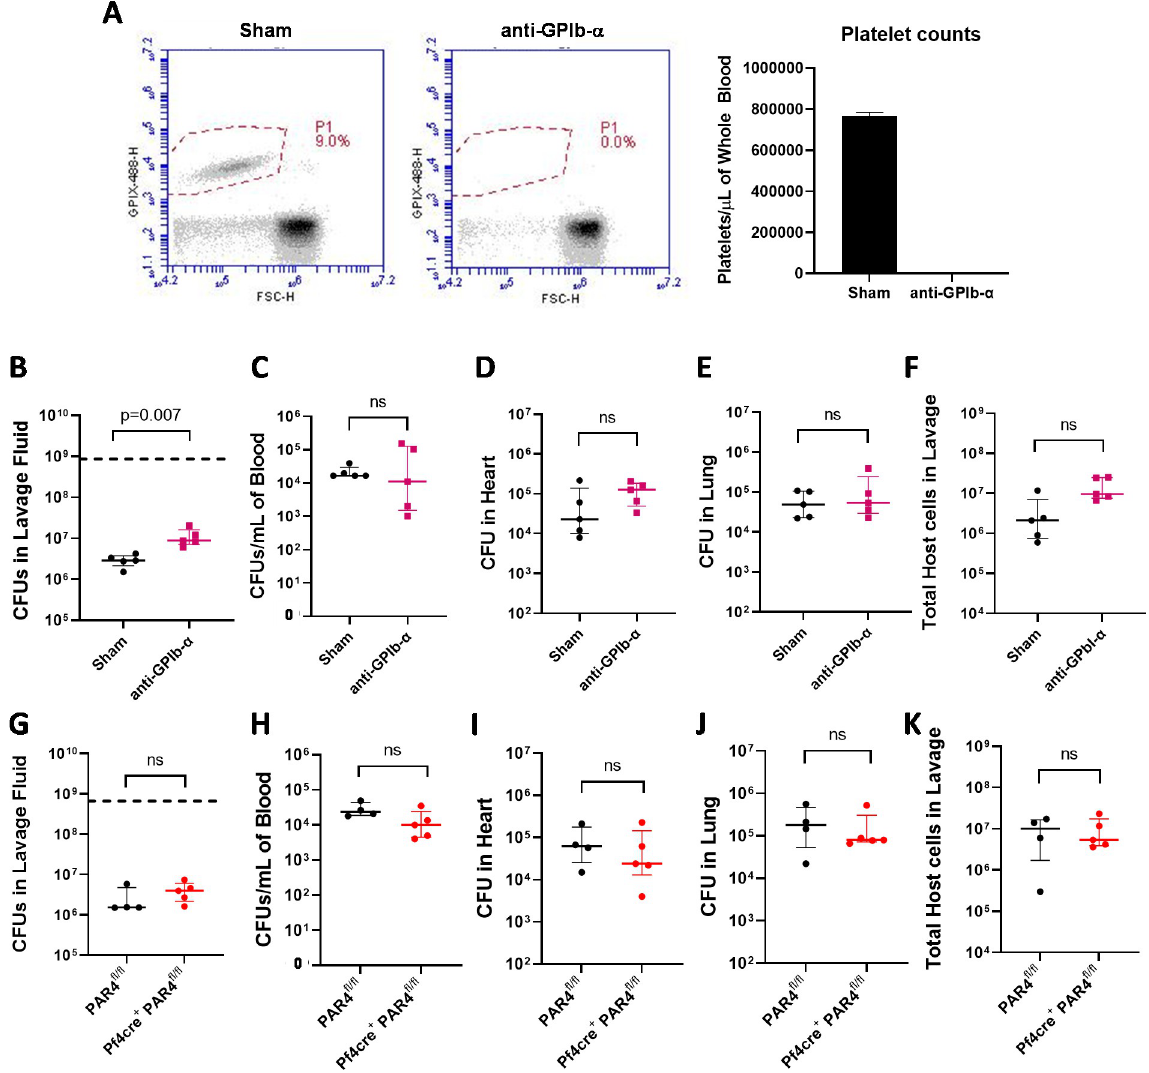
Fig 5. Platelets but not platelet-derived protease-activated receptor-4 are important for local S. aureus clearance from the peritoneal cavity. (A) Flow-cytometry analysis of platelet depletion following i.v. injection with anti-GPIb- α antibodies. Total bacterial CFUs in the peritoneal (B) lavage fluid, (C) blood, (D) heart and (E) lung of sham injected and platelet-depleted mice 1 hour after i.p. infection with 8x10 8 CFUs of WT S . aureus USA300. (F) Total cell counts from peritoneal lavage fluid of sham injected and platelet-depleted mice 1 hour after infection with WT S . aureus USA300. Total bacteria CFUs in the peritoneal lavage (G) fluid, (H) blood, (I) heart and (J) lung of PAR4 fl/fl and Pf4-cre + /PAR4 fl/fl mice 1hr after i.p. infection with 6.57x10 8 CFUs of WT S . aureus USA300. (K) Total cell counts from peritoneal lavage fluid of PAR4 fl/fl and Pf4-Cre + /PAR4 fl/fl mice 1 hour after infection with WT S . aureus USA300. Dashed horizontal lines indicate the infection dose. Data are presented as mean ± SEM and statistical significance was determined by Mann-Whitney